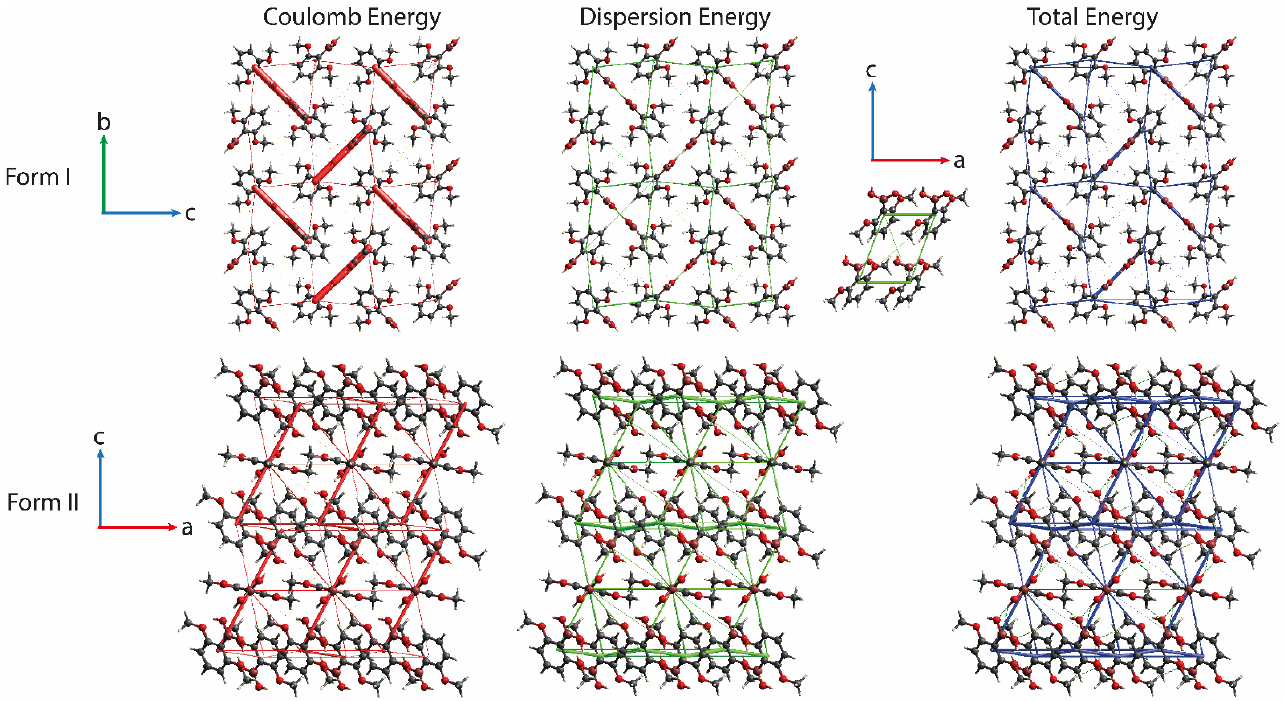
Figure 7. Energy-framework diagrams for E Coul , E dis and E tot for MPBA Forms I and II. All images have the same tube size.